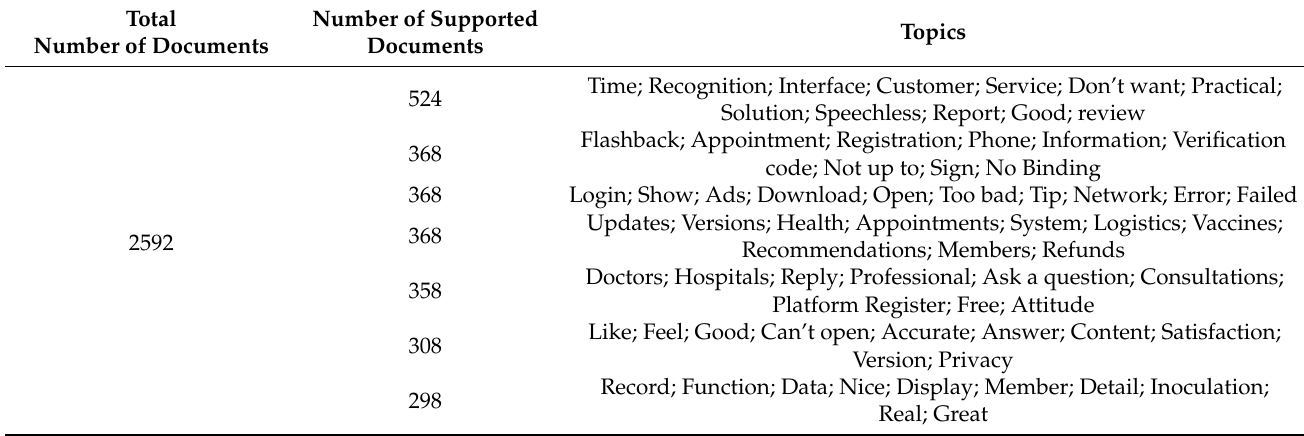
Table 3. Top 7 topics and subject terms for online reviews of mobile medical